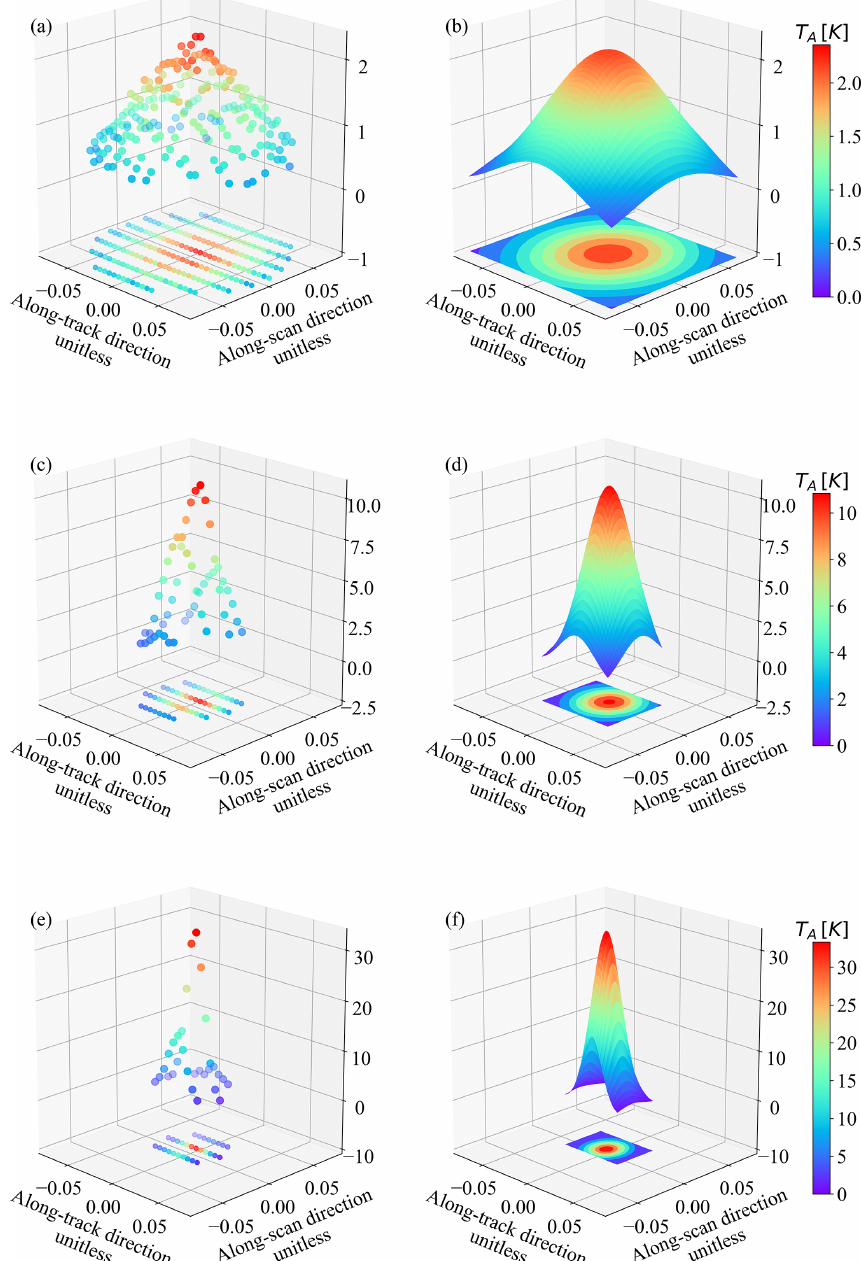
Figure 4. Raw observations (the first column) and their fitted two-dimensional Gaussian function (the second column) of channels 1 (a–b) , 3 (c–d) , and 17 (e–f) in the antenna pattern coordinate